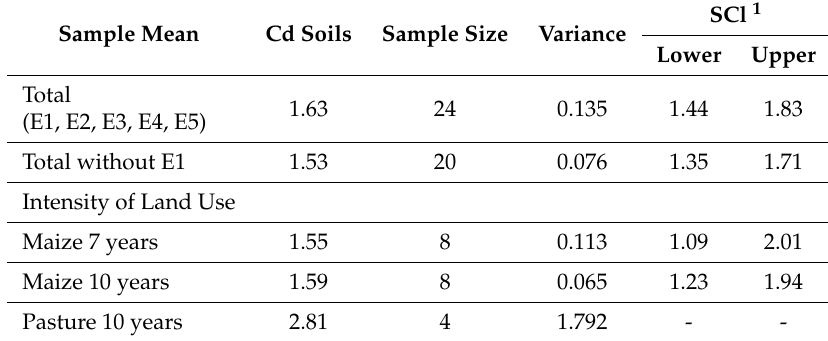
Table 4. Average content of Cd in soil according to total productive unit and intensity of land use